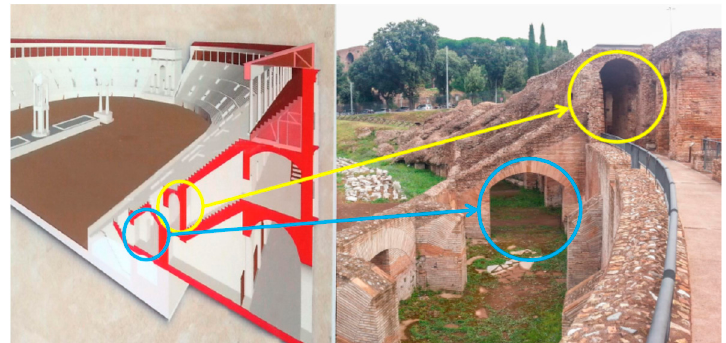
Figure 3. Schematic view of the original structure (courtesy of the Superintendence) and present structure.